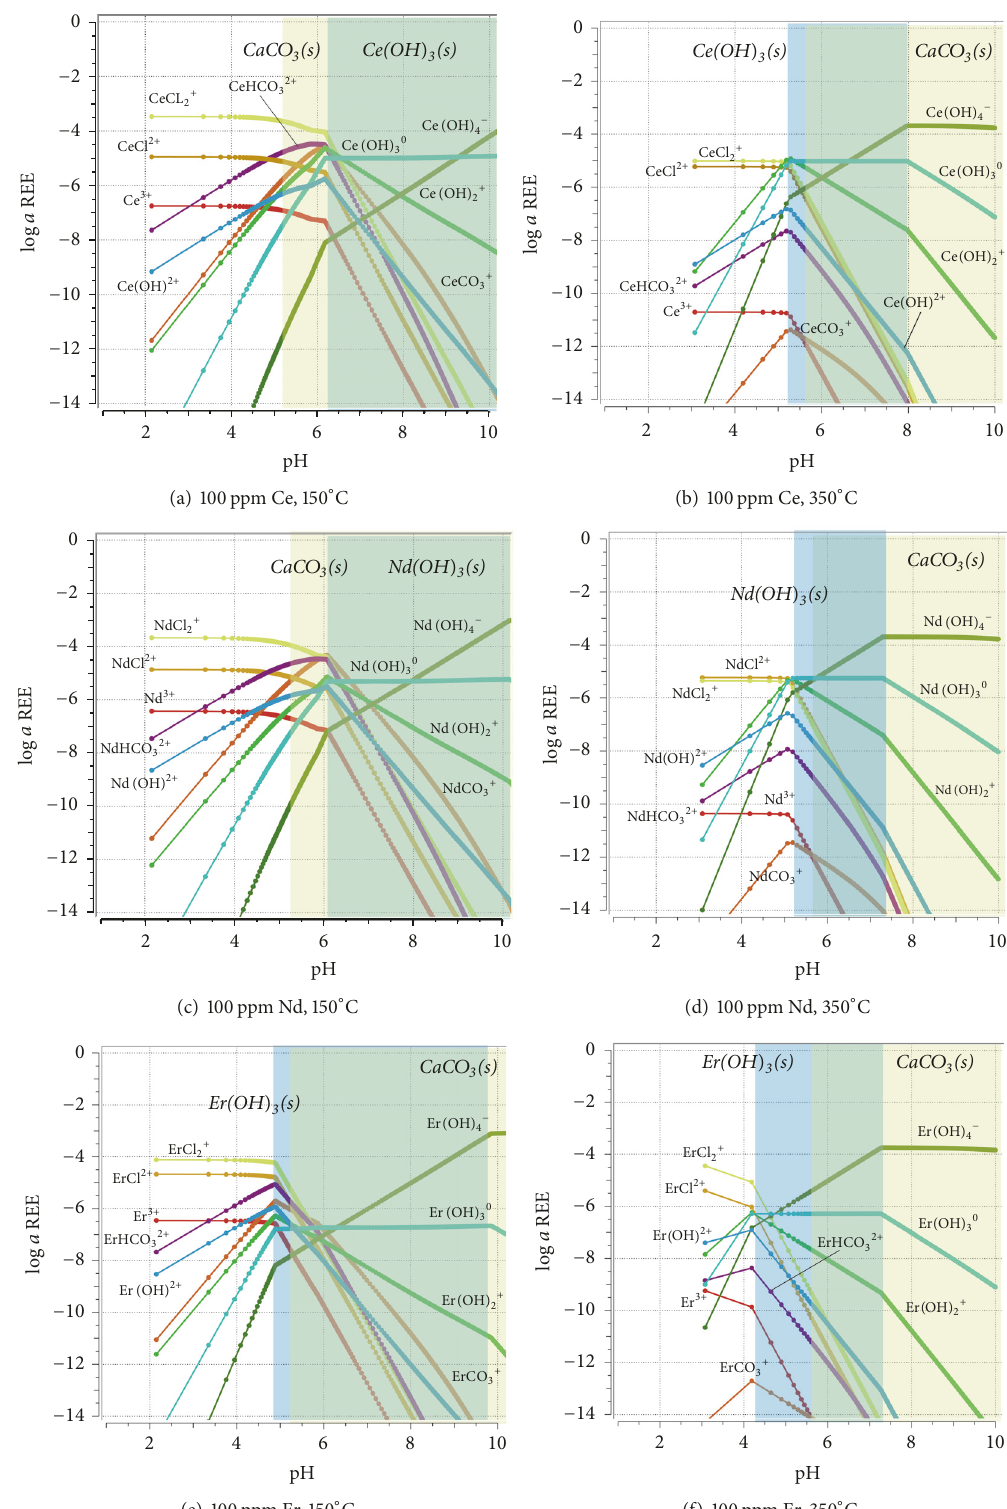
Figure 3: Model Ic (CO 2 -NaCl-rich) showing the speciation of REE in a deeper carbonatite system. Results show the speciation of Ce, Nd, and Er as function of pH at 150 to 350 ∘ C and 1 kbar. The starting fluid had a composition of 100ppm REE, 𝑋 CO 2 of 0.1, and 20 wt.% NaCl. The blue field represents the field of REE(OH) 3 (s) stability, while the yellow field corresponds to the stability field of